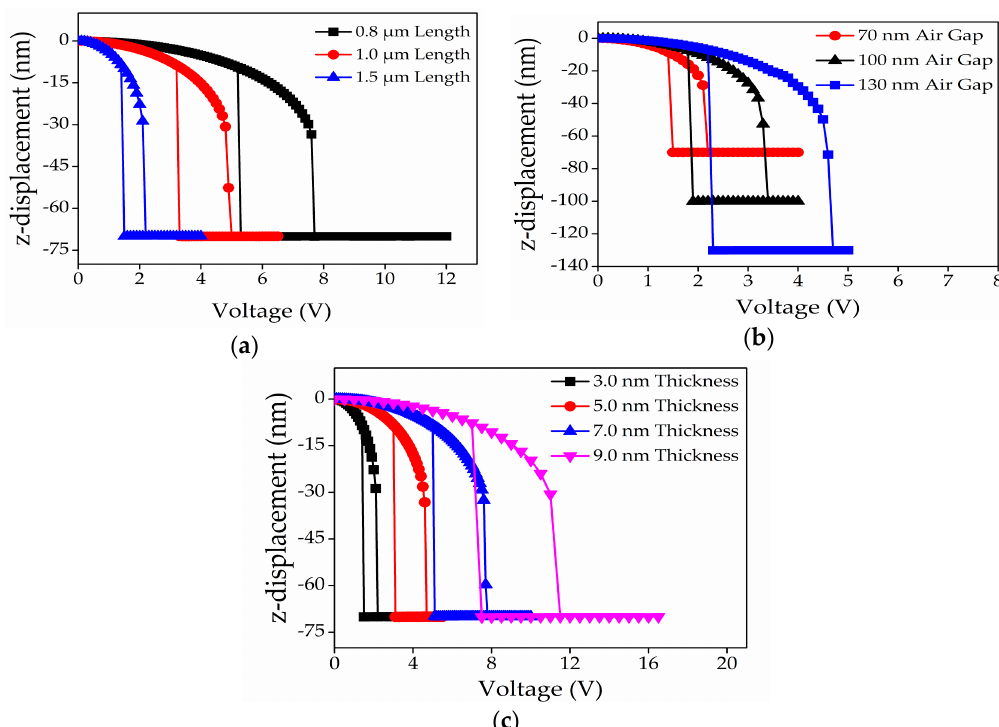
Figure 6. Actuation pull-in voltage characteristics of a fixed-fixed ends graphene-based NEM switch for variation of: ( a ) beam length; ( b ) air gap thickness; ( c ) beam thickness.